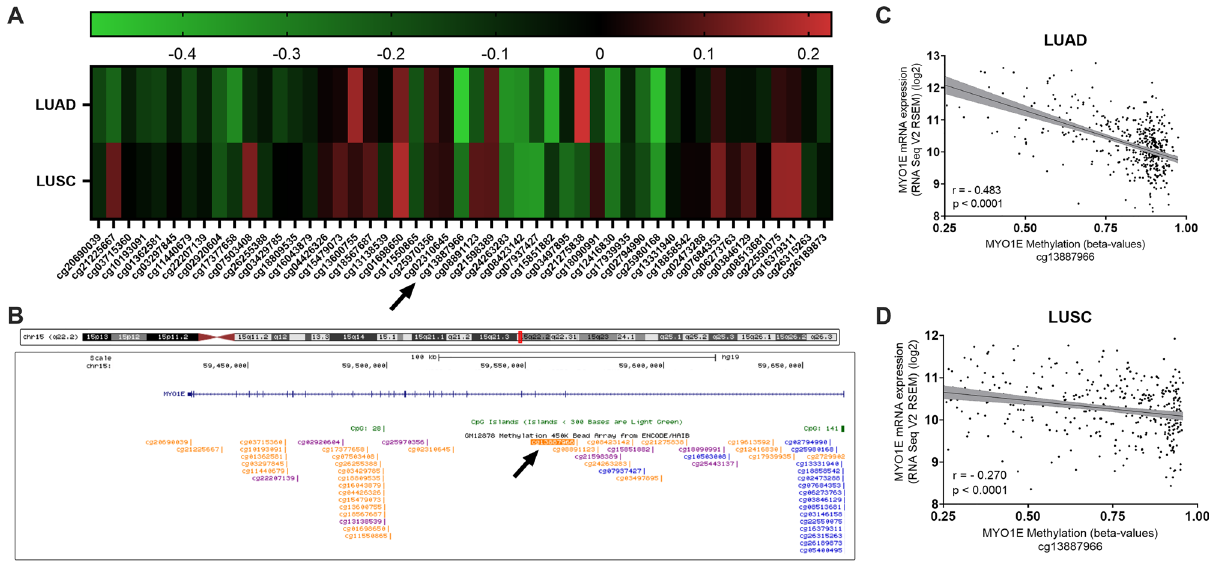
Figure 1. Strong inverse correlations are observed between cg13887966 DNA methylation intronic probe and MYO1E RNA expression for LUAD and LUSC. ( A ) Heatmap showing Spearman’s correlation coefficients for MYO1E RNA expression and all CpG dinucleotides probes for MYO1E DNA methylation ordered by genomic position in LUAD and LUSC. Red represents direct correlation and green inverse correlation (p < 0.05 “*”; p < 0.01 “**”; p < 0.001 “***”). ( B ) Schematic representation of the relative genomic position of the different CpG probes for MYO1E showing that cg13887966 is located on MYO1E’s 1st intron. ( C ) and ( D ) Scatterplots showing the correlation between RNA expression and cg13887966 probe for MYO1E DNA methylation in LUAD ( C ) and LUSC ( D